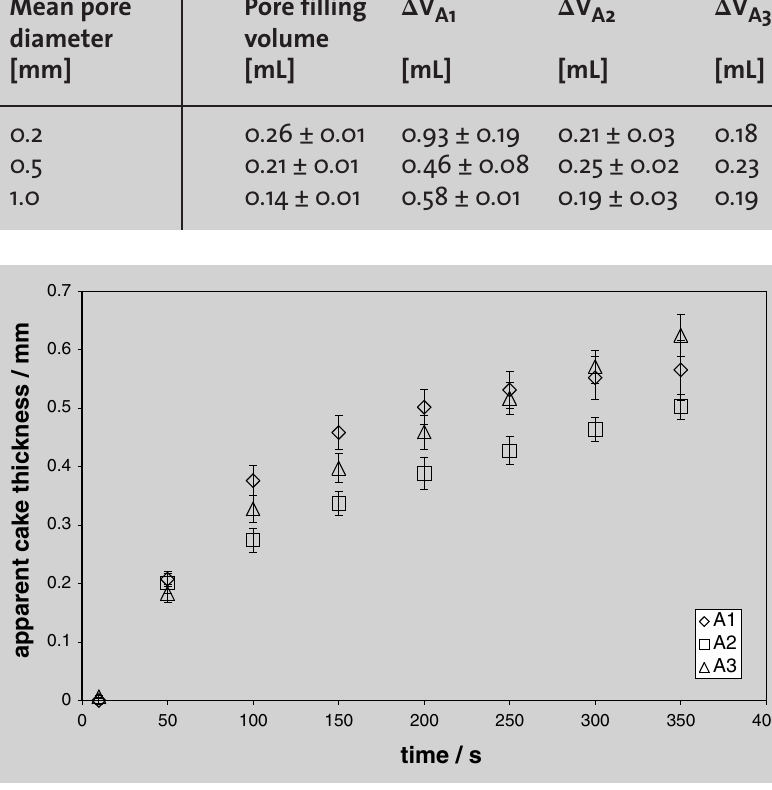
Table 2 (above): Results from the measurements of pore filling volume (total pore volume) for three types of Teflon filter and the change in suspension volume ( D V) up to the point at which the slope of the suspension volume versus time-curve changes. The measurements were performed at 25˚C and pH = 8.5. The ranges indicat- ed refer to standard devia- tions. The results from mea- surements of A3 originate from single measurements but are included since only minor deviations in the results were observed for colours A1 and A2. Figure 4 (below): Apparent filter cake thick- ness at different times. Results for coating colours A1, A2 and